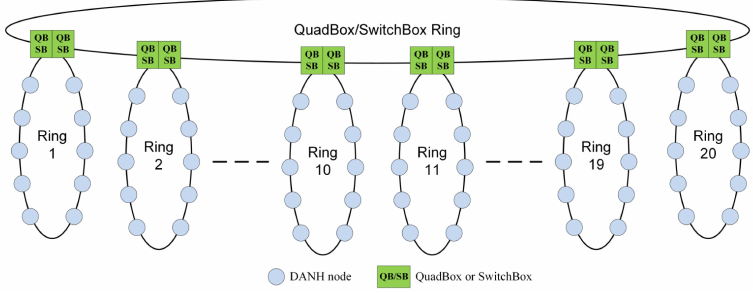
Figure 25. The sample HSR network in case 2 of Simulation